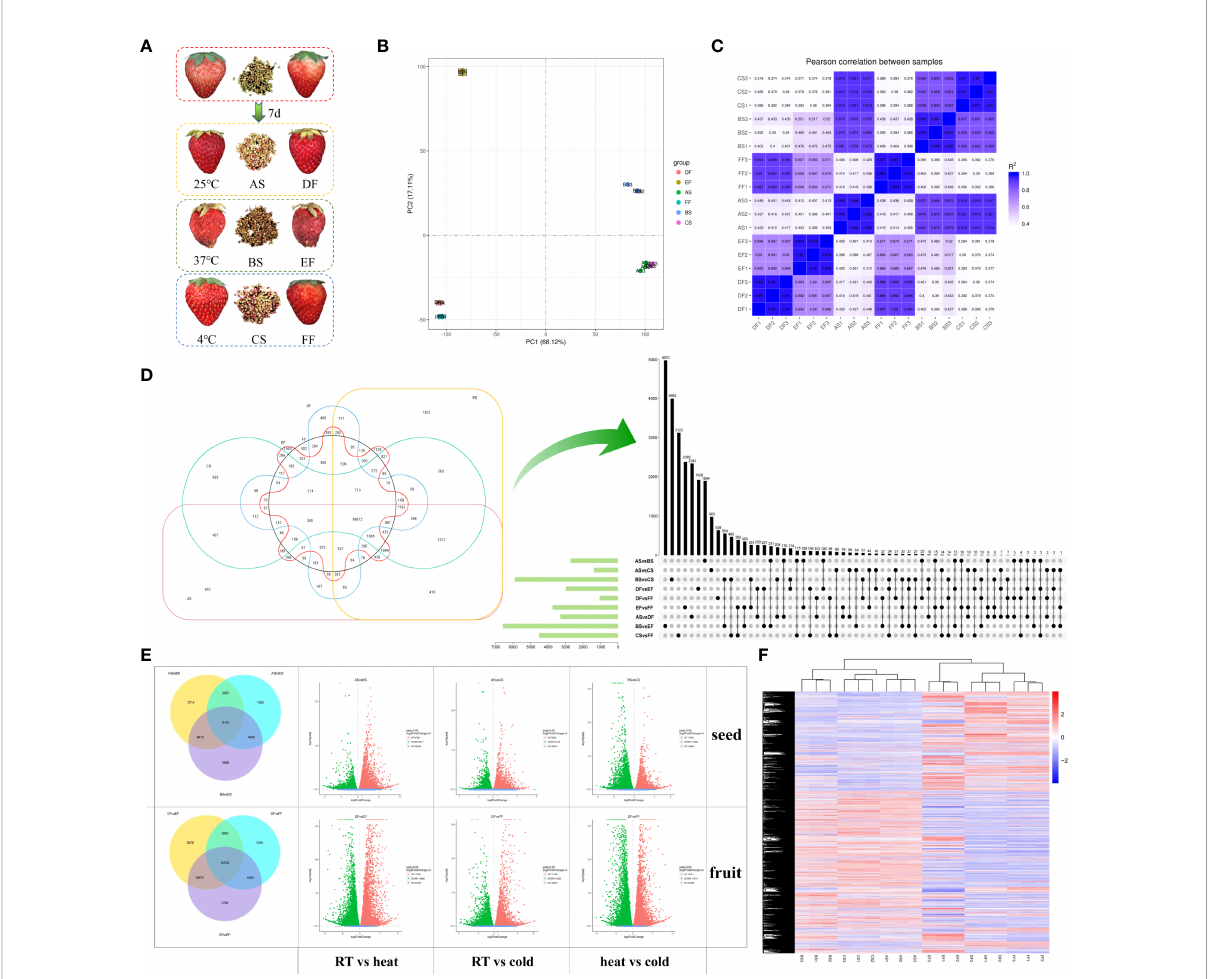
FIGURE 1 Differentially expressed genes (DEGs) in seeds and fruits of strawberries after 7 days under different storage temperature modes. (A) Strawberry fruits and seeds under different storage temperatures; (B) Principal component analysis (PCA) scatter plot of different samples based on the transcriptomic pro fi les; (C) Correlation coef fi cient graph of all samples; (D) DEGs in samples treated at cold, RT, and heat treatments. The 6- element Venn diagram was used to represent the number of genes with no difference in expression between different groups. The Upset diagram was used to more closely represented the intersection between different temperatures and samples. The green bar graph represents the size of each combination, while the black dot represents yes, the gray dot represents none, and the black bar graph represents the number of intersections. (E) Volcano map for the signi fi cance level of the DEGs. The horizontal axis represents the fold change of DEGs, and the vertical axis represents the signi fi cance level of the difference. Padj indicates the corrected p value after the multiple hypothesis test, the same as below. (F) Comparison of the transcription level of DEGs using heatmap analysis. Samples were divided into two groups including seeds (RT (AS), heat (BS), and cold storage (CS)) and fruits (RT (DF), heat (EF), and cold storage